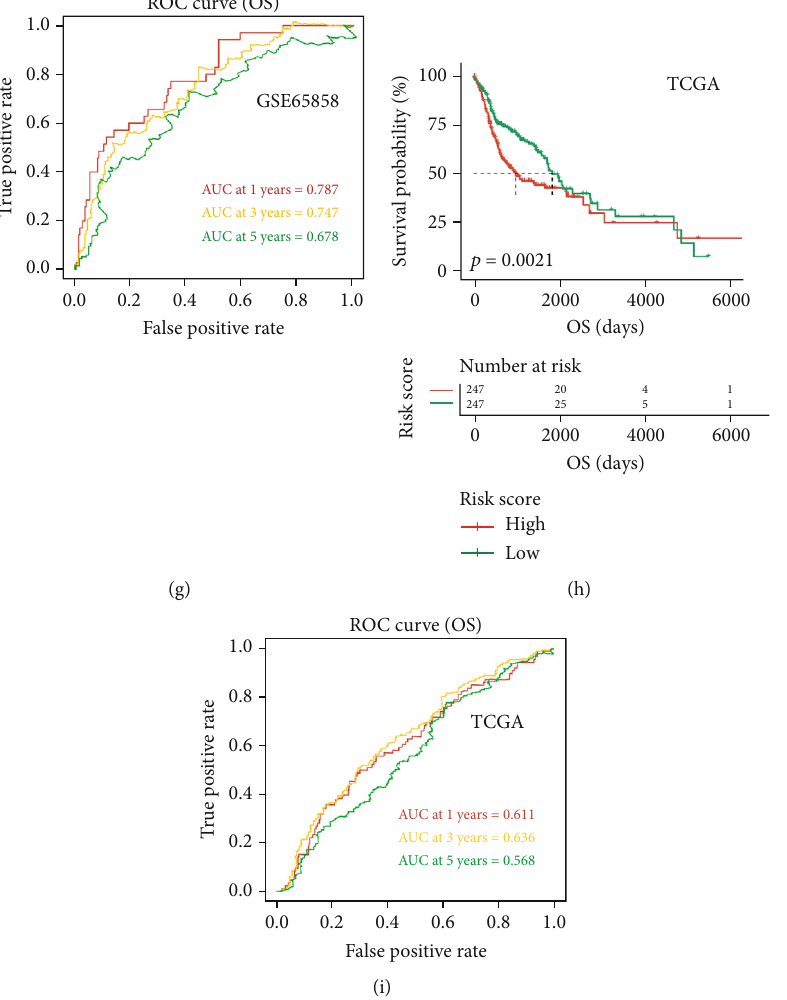
Figure 6: Construction of the IRDEG prognostic classi fi er, the distribution of time-dependent ROC curves, and Kaplan-Meier survival: (a, b) determination of the number of factors by LASSO analysis; (c) distribution of risk scores; (d) survival duration and status of patients; (e) heatmap of IRDEGs in the classi fi er; (f) Kaplan-Meier curve of the GSE65858 cohort; (g) ROC curve for the GSE65858 cohort; (h) Kaplan-Meier curve of the TCGA HNSCC cohort; (i) ROC curve for the TCGA HNSCC cohort.